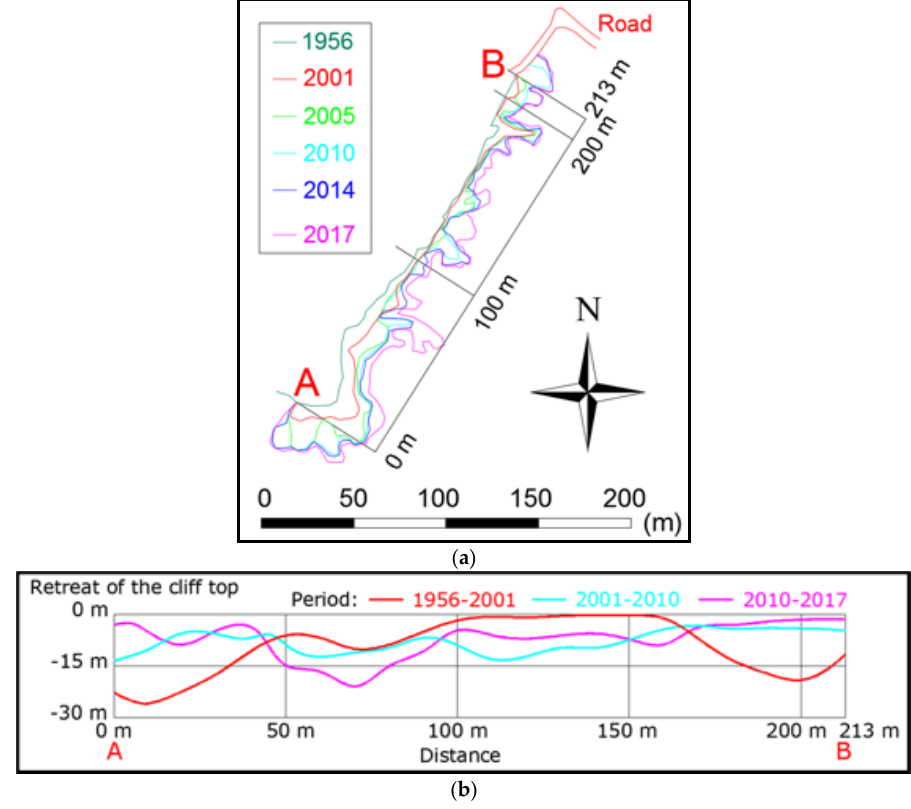
Figure 6. ( a ) Evolution of the cliff top between A and B. Lines of the years 1956, 2001, 2005, 2010, 2014 and 2017; ( b ) Comparison of the retreat of the cliff top in the periods 1956–2001, 2001–2010, and 2010–2017.